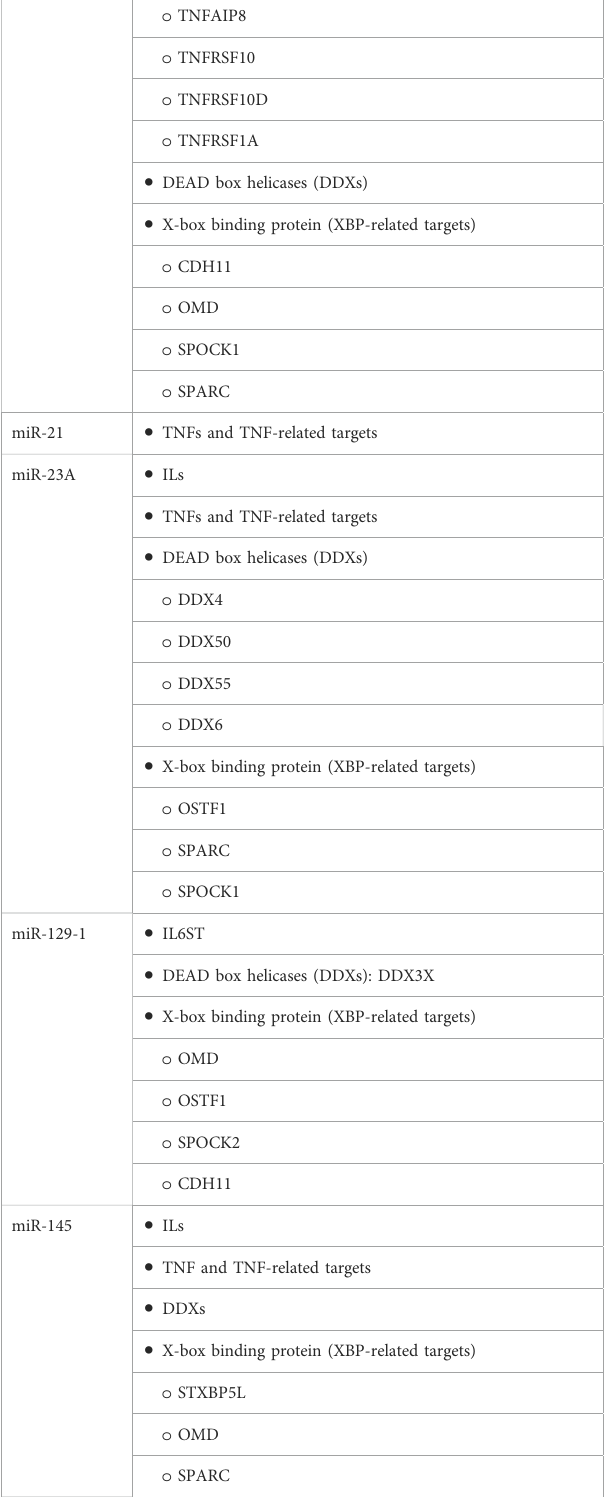
miR-21 targets Suppressor of Mothers against Decapentaplegic7 (Smad7), sprouty RTK signaling antagonist 1 (Spry1) and periodontal-ligament-associated protein-1 (PLAP1) to improve osteogenic differentiation (Santini et al., 2003; Oteri et al., 2008; Allegra et al., 2010). miR-21 determines upregulation of osteoclastogenesis via enhancing receptor activator of nuclear factor kappa-B ligand (RANKL) and suppressing osteoprotegerin (OPG) expression (Alonci et al., 2007). miR-21 is related to particle induced osteolysis pathogenesis (Allegra et al., 2007), and knocking down miR-21 leads to osteoclastogenesis restriction (Katz et al., 2011). Circulating miR-21 is upregulated during MRONJ progress, which is consistent with miR-21 variation in pro-osteoclastogenesis (Continued in next column) (Yang et al., 2018).